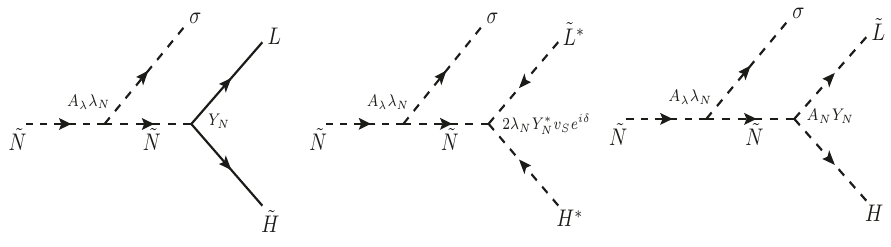
Figure 2 . 3-body decay diagrams of singlet sneutrino, ~ N at higher